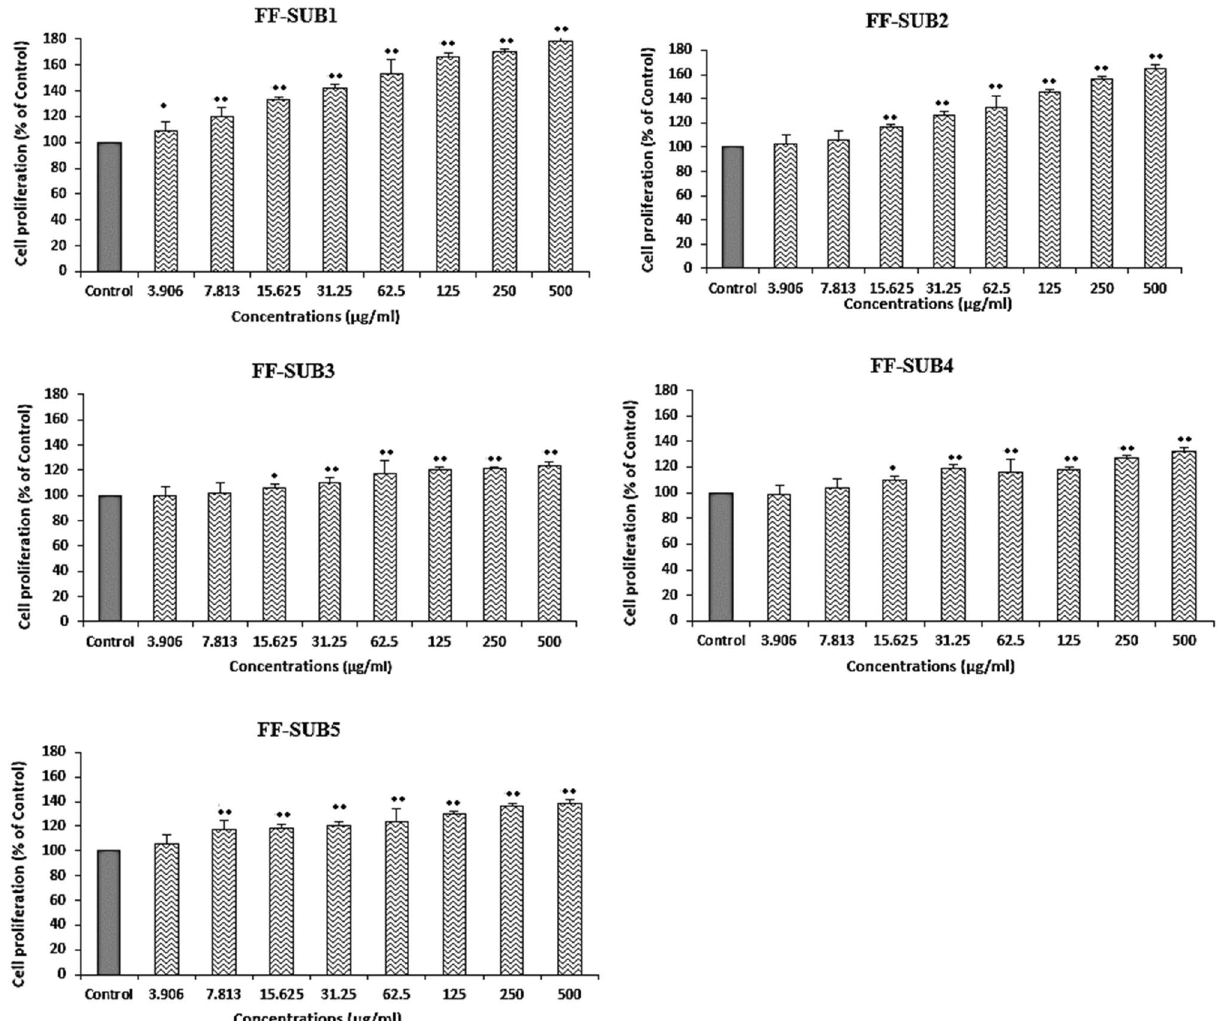
Figure 6. Effects of five subfractions of Fr. F, namely FF-SUB 1 to FF-SUB 5 , on the proliferation rate of Hs.27 fibroblast cells. All bars and values represent the mean ± SD of three replicate experiments. *Significant difference (P < 0.05) and **P < 0.01 when compared to the control